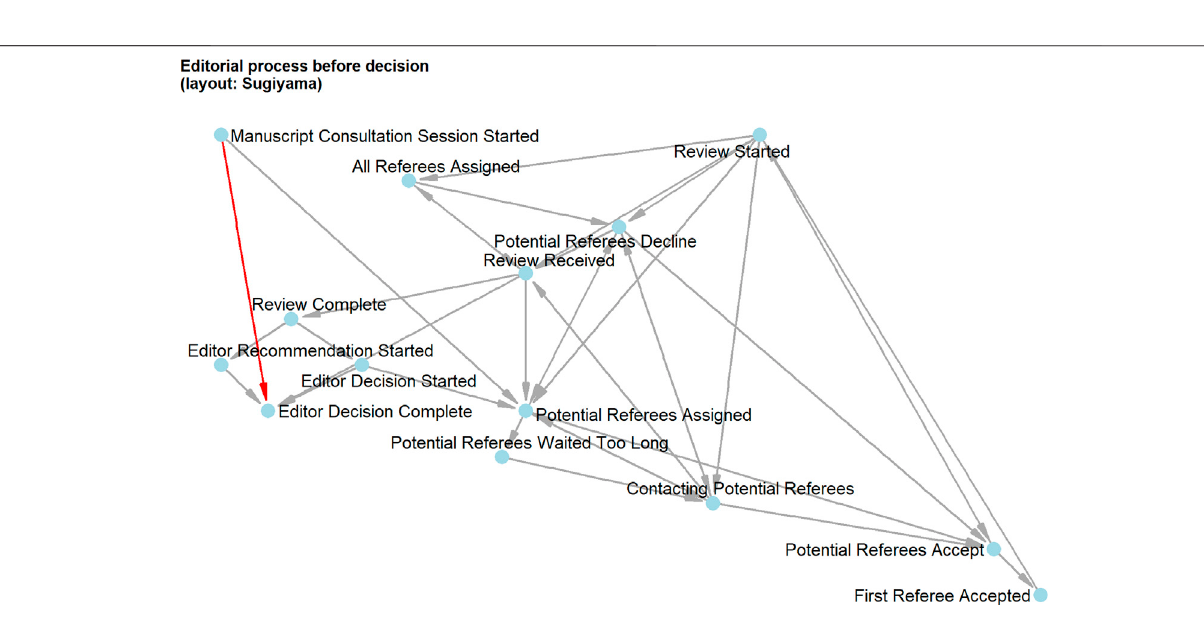
Frontiers in Research Metrics and Analytics |